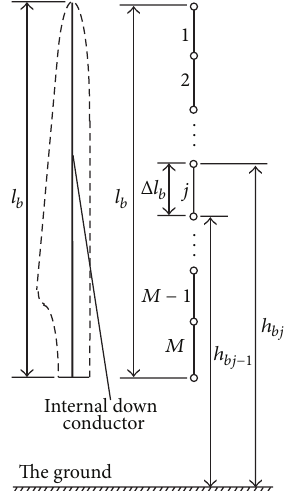
Figure 1: Segmentation of down conductor.